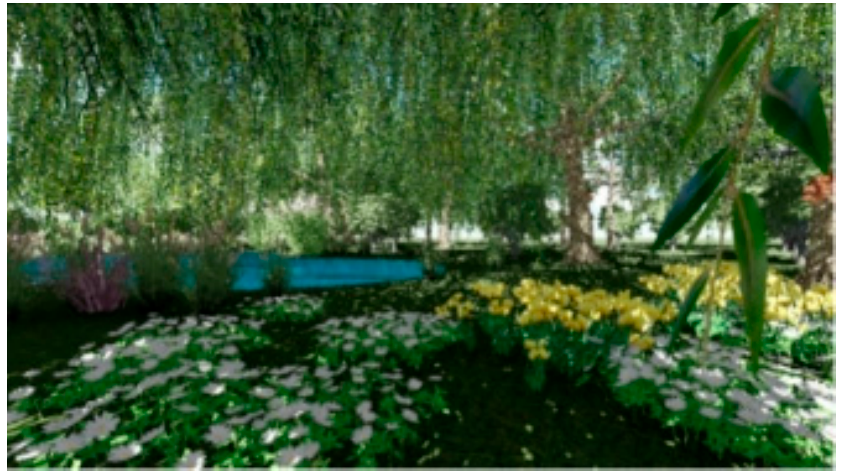
Figure 2. Example 2 of an experimental picture.